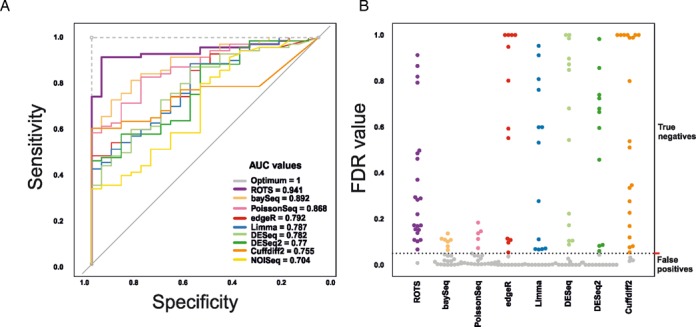
Efficient detection of spiked material. (A) Receiver Operating Characteristic (ROC) curves of the different statistical methods in the spike-in data together with the areas under the curves (AUC). (B) False discovery rate (FDR) values of the non-differentially expressed spiked controls. The gray dots correspond to false positive detections at FDR < 0.05.